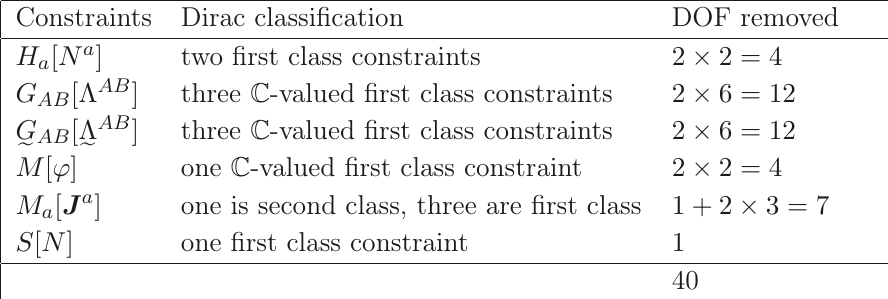
A A , which parametrise 2 π Ba , A , ℓ e e e